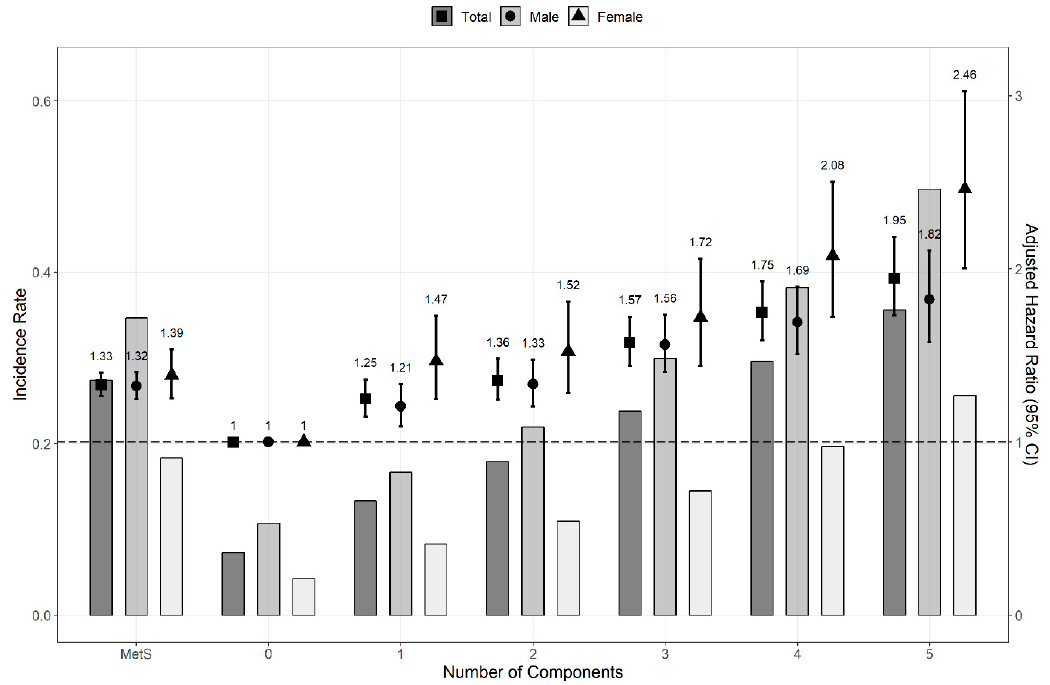
Figure 2. Hazard ratios and incidence rate for the risk of kidney cancer by numbers of MetS components (overall periods). Cox proportional hazard regression model was adjusted for age, sex, smoking status, alcohol consumption, body mass index, and regular physical exercise. When the analysis was conducted based on sex, the factor sex was excluded. Abbreviation: CI, confidence interval; MetS, metabolic syndrome.